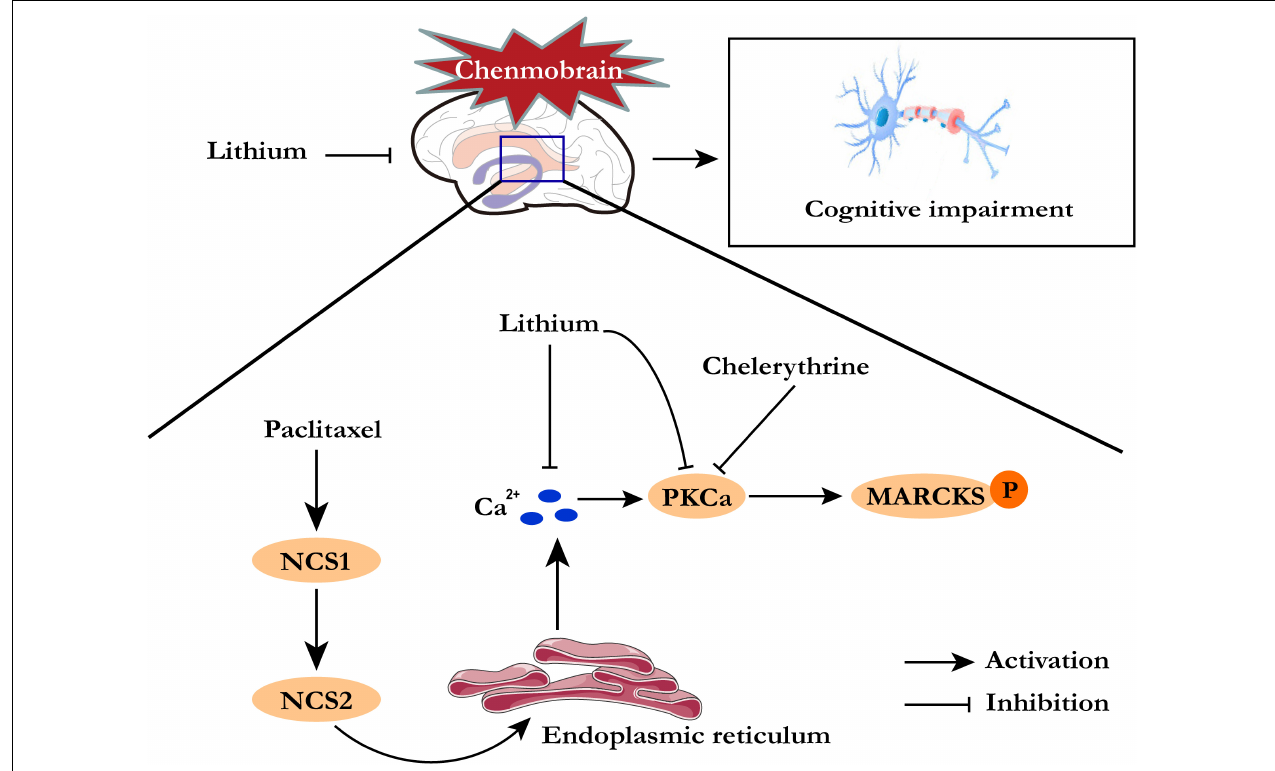
FIGURE 1 | Lithium pretreatment for paclitaxel-induced cognitive